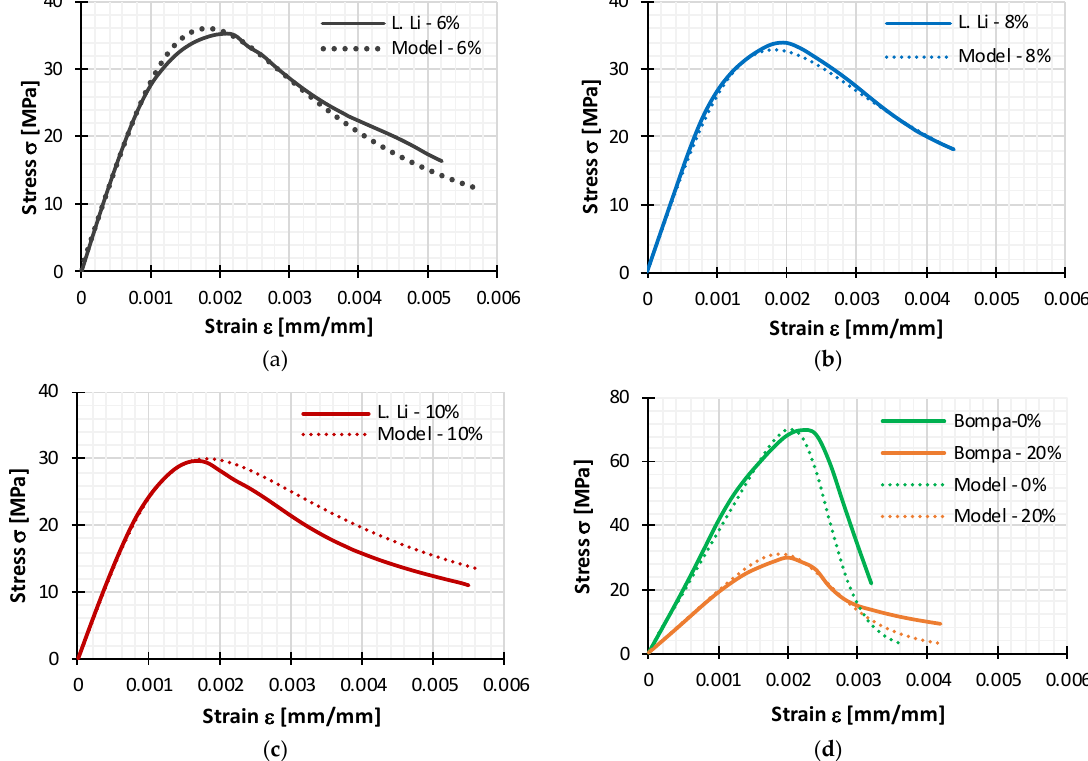
Figure 12. Comparison of experimental stress-strain curves for ( a ) tire rubber concrete with 6% rubber aggregate; ( b ) tire rubber concrete with 8% rubber aggregate; ( c ) tire rubber concrete with 10% rubber aggregate (data from L. Li [18] for tire rubber concrete with rubber aggregate of 2 mm size); ( d ) normal concrete with 0% rubber aggregate and for rubberized concrete with 20% rubber aggregate (data from D.V. Bompa et al.